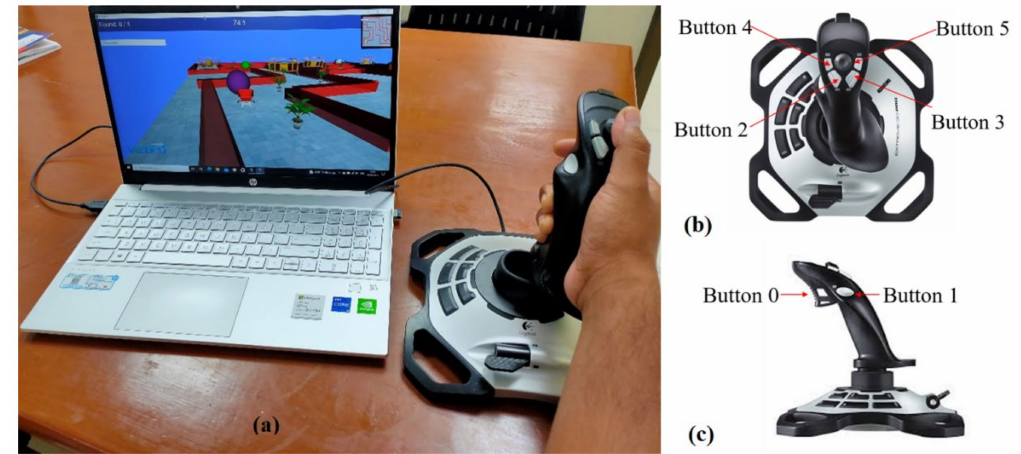
Figure 1. ( a ) VR setup with joystick and the subject performing the tasks, ( b ) top view of the joystick, and ( c ) side view of the